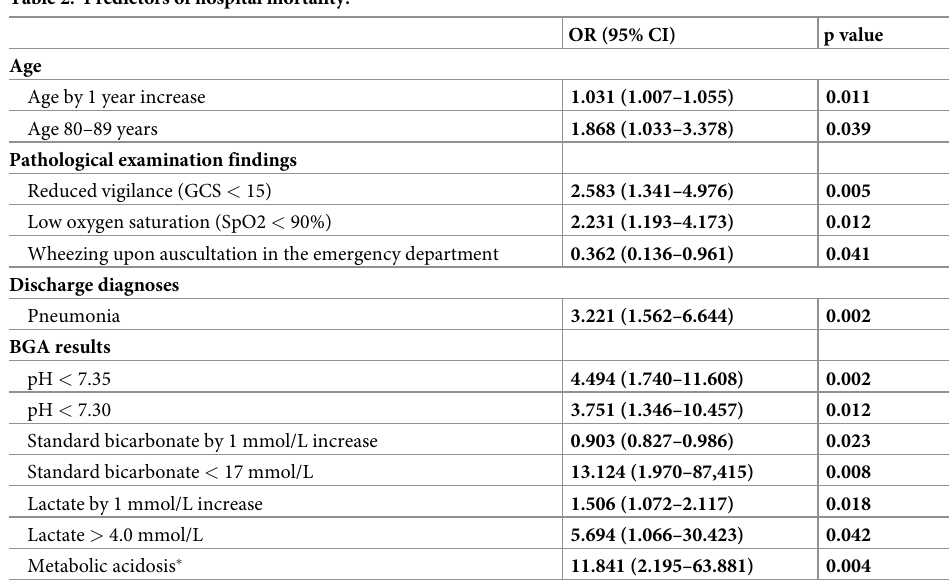
Table 2. Predictors of hospital